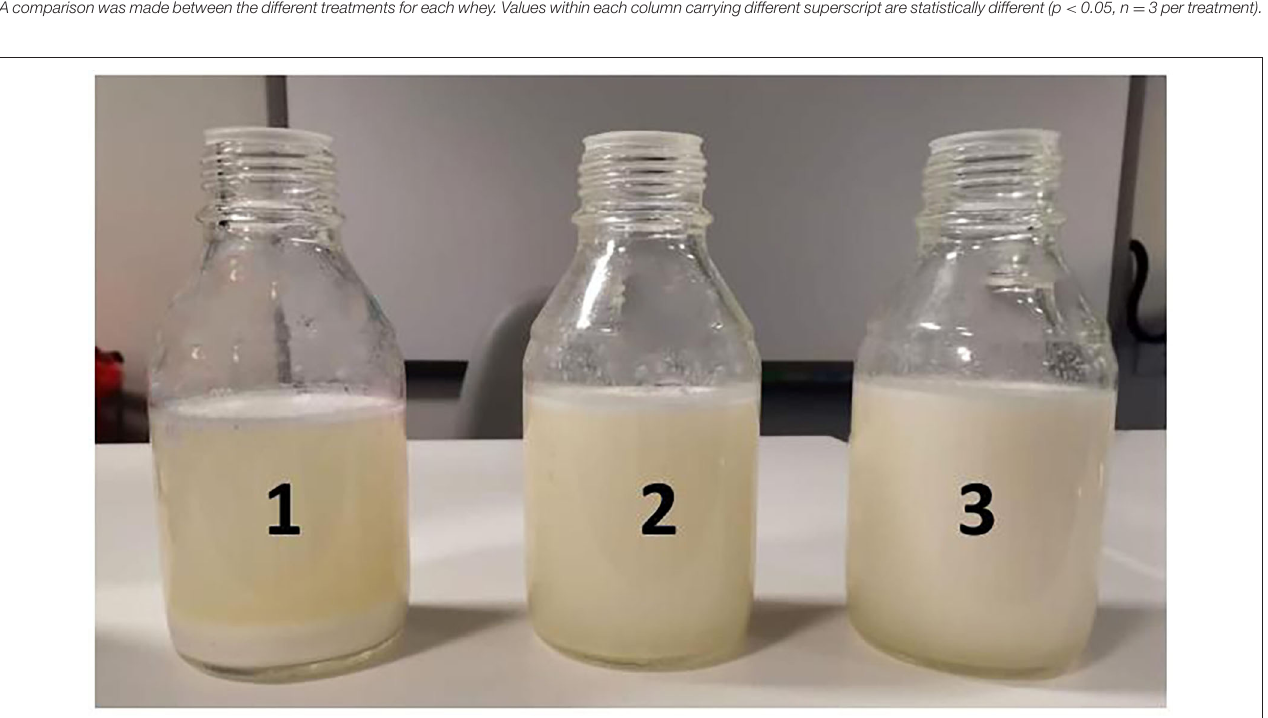
FIGURE 6 | The whey fractions from cheeses produced from camel milk (1) pasteurized (75 ◦ C, 30s), (2) HPP (350 MPa, 5min at 4 ◦ C), and (3) HPP (550 MPa, 5min at 4 ◦